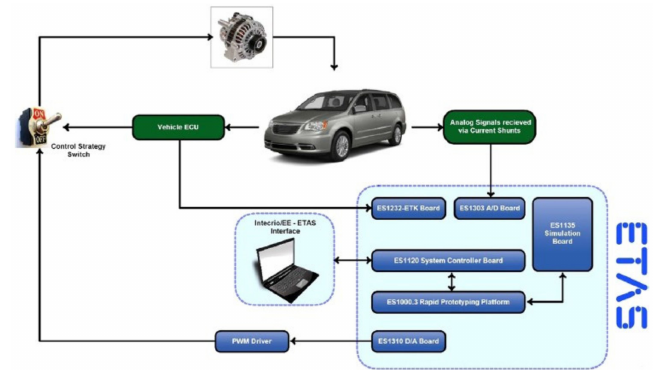
Figure 1. Block diagram for the experimental test rig